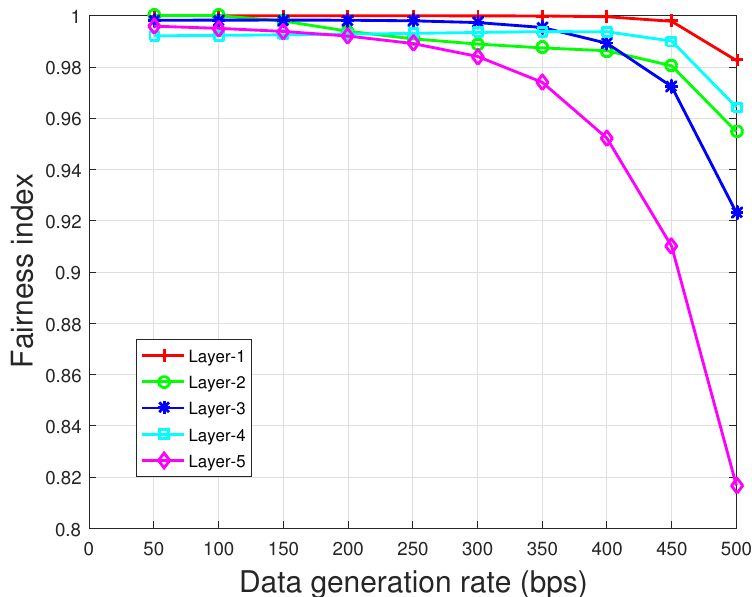
Figure 21. Comparison of fairness index at different layers in sparse